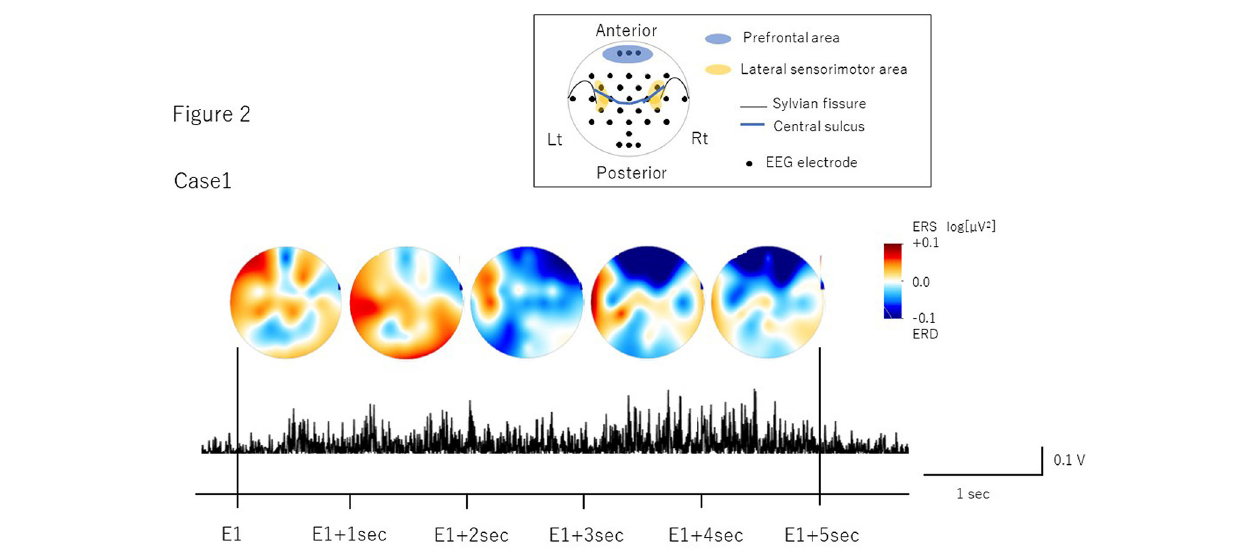
FIGURE 2 | The topographic mapping of the averaged ERD/ERS and the EMG of submental group muscles in Case 1. The topographic mapping display of the swallow-related ERD or ERS every 1s and the EMG of submental group muscles during a single swallow in Case 1 are shown. ERD/S are color-coded on the topomap display. ERD is prominent in the bilateral prefrontal areas from 3s after the onset of swallowing to the end of swallowing.